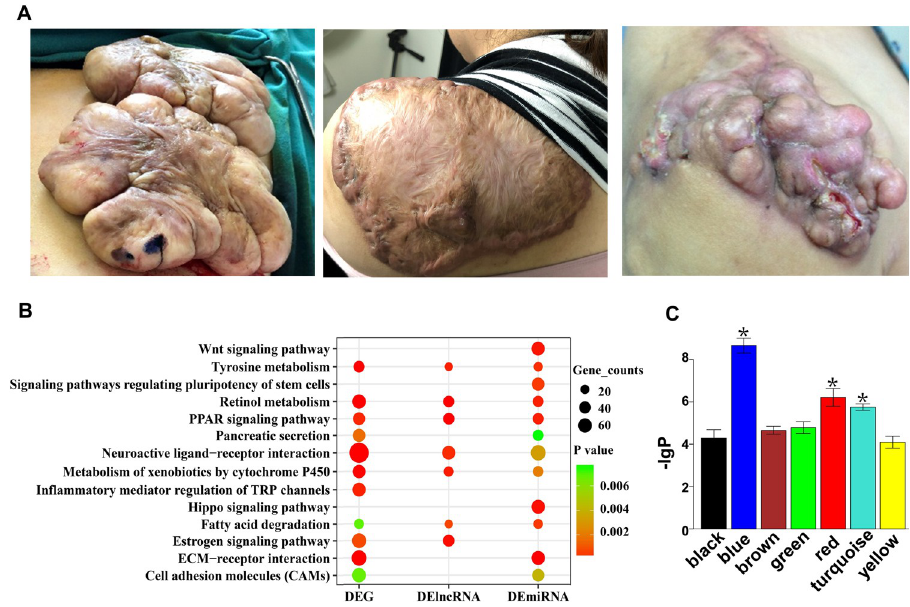
Fig 2. Keloid lesion gross appearance and enriched KEGG pathways and WGCNA (weighted gene co-expression network analysis) identified modules. (A) Gross appearance of three selected keloid lesion samples. (B) Identification of the differentially expressed signalling pathways between keloid lesions and adjacent normal skins by KEGG enrichment of DERNAs (mRNA, miRNA and lncRNA-targeted mRNA). (C) Seven gene co-expression modules represented by 7 different colors were detected by WGCNA analysis of the paired DEG and DElncRNA and the modules of blue, red and turquoise showed most significantly differentially expressed between keloid lesions and adjacent normal skin